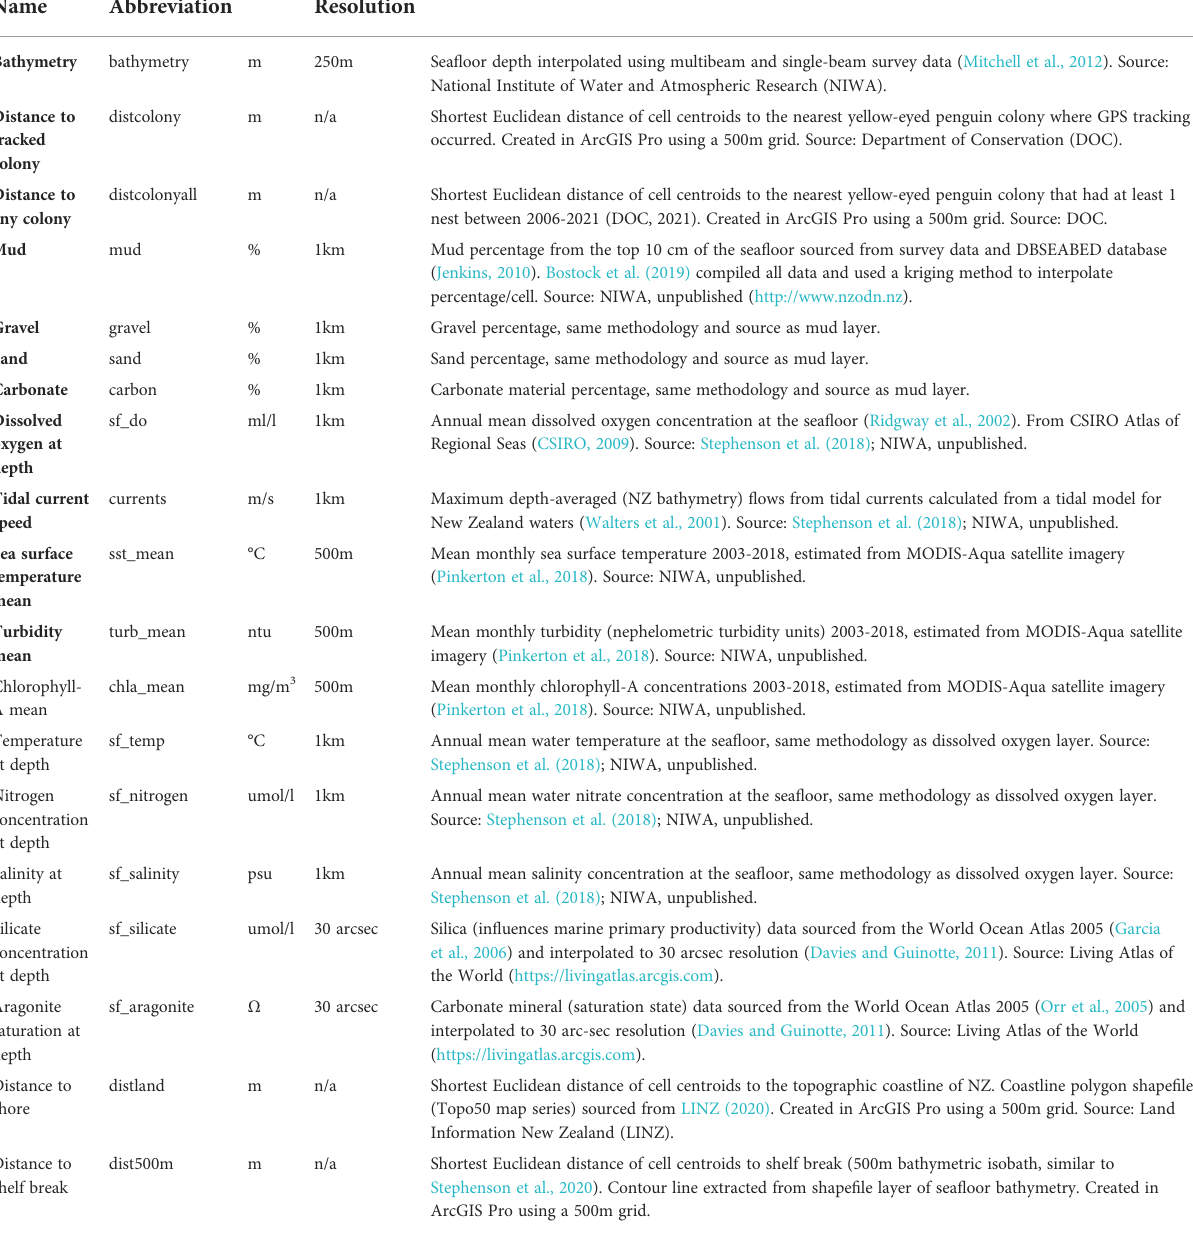
TABLE 2 Environmental predictor variables considered in Maxent species distribution